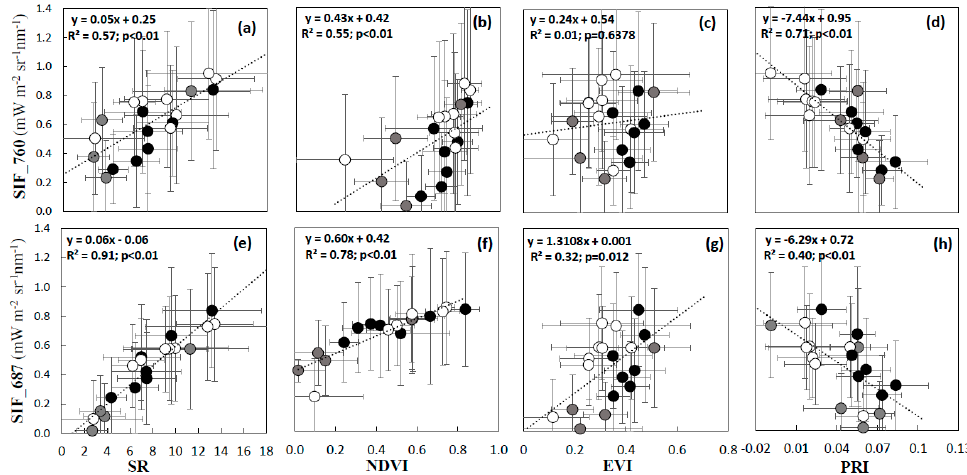
Figure 8. Correlation analysis of SIF at 760 nm (Figure 8a–d) and at 687 nm (Figure 8e–h) with selected remotely sensed VIs (SR, NDVI, and PRI) at the vegetation group level. Error bars represent standard deviation. Here, black dots denote peatland, light grey dots denote grasslands, and white represents forest vegetation groups.